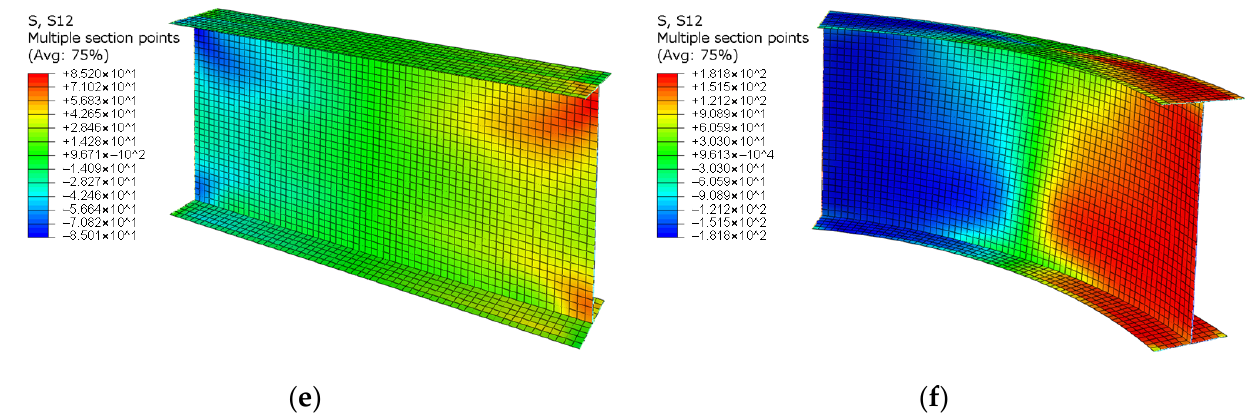
Figure 7. Failure Mode of Straight and Curved Girders; ( a ) normal stress distribution (Str); ( b ) normal stress distribution ( θ = 60 ◦ ); ( c ) Von Mises’ stress distribution (Str); ( d ) Von Mises’ stress distribution ( θ = 60 ◦ ). ( e ) Shear stress distribution (Str); ( f ) Shear stress distribution ( θ = 60 ◦ ). * Middle layer.